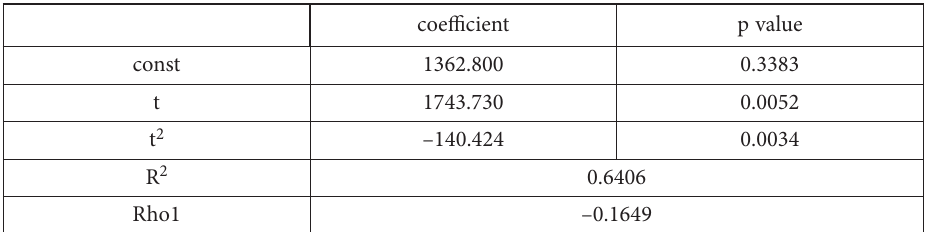
Table 4. The trend model of the bankruptcy in the Czech Republic in the years 2005–2016 (source: Own work)